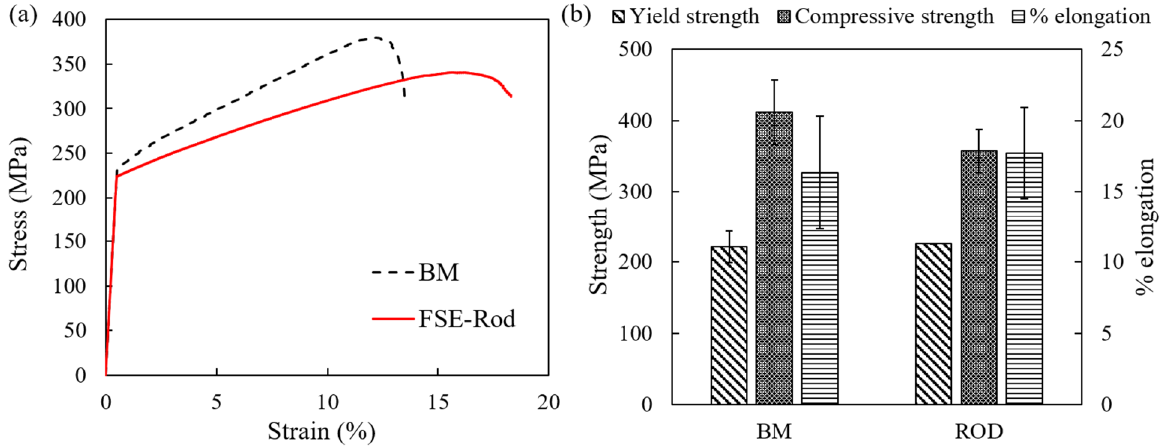
Figure 12. ( a ) Compression stress–strain curve for the base material and FSE rod. ( b ) Comparison of yield strength, compressive strength, and ductility obtained from the compression stress–strain curves.